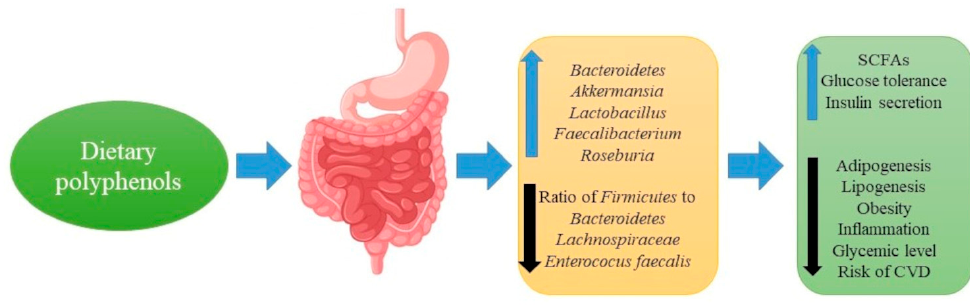
Figure 3. Influence of the dietary polyphenols on the gut microbiota and possible outcome; SCFAs—short-chain fatty acids.